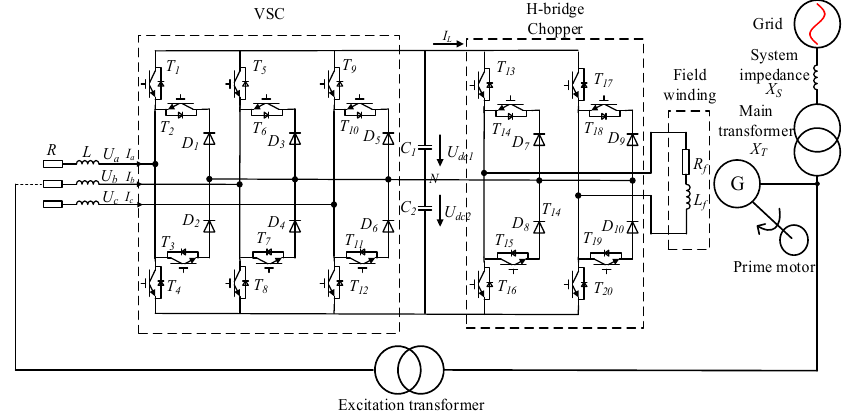
Figure 1. Three-level voltage source flexible excitation system.